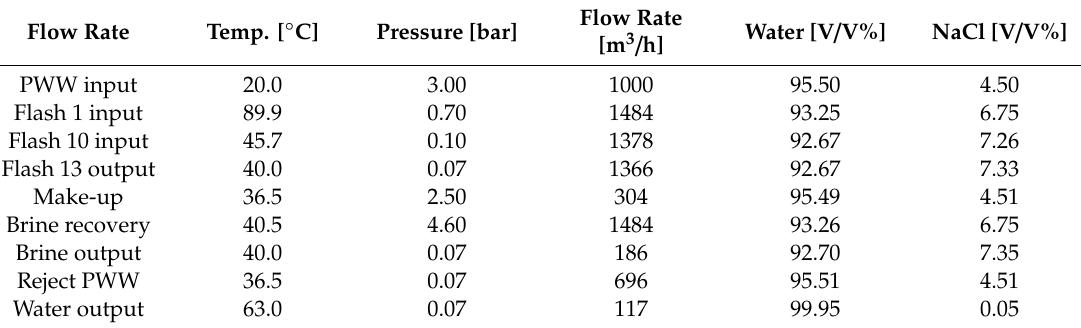
Table 5. Optimized results of multi-stage flash distillation